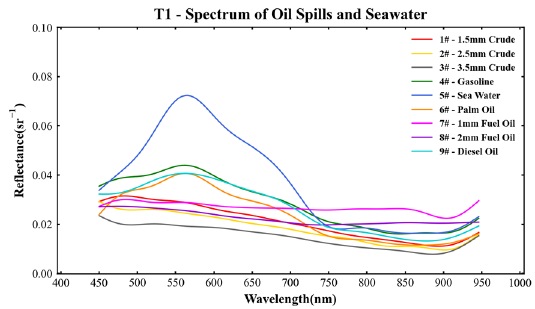
Figure 10. Remote sensing reflectance of the oil spills at T1.